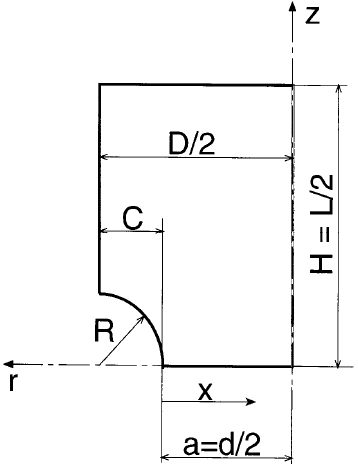
Figure 9. Dimensions of the notched geometries.